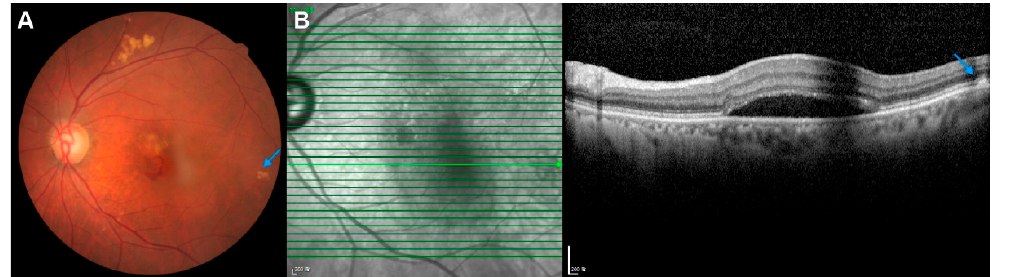
Figure 2. Representative cases of pachydrusen in PCV eye. ( A ) An 80-year-old male patient presented with subretinal hemorrhage due to PCV in his left eye, with a pachydrusen (blue arrows) at the temporal retina in FP. ( B ) Pachydrusen is noted at the temporal side in OCT. OCT = optical coherence tomography; PCV = polypoidal choroidal vasculopathy.